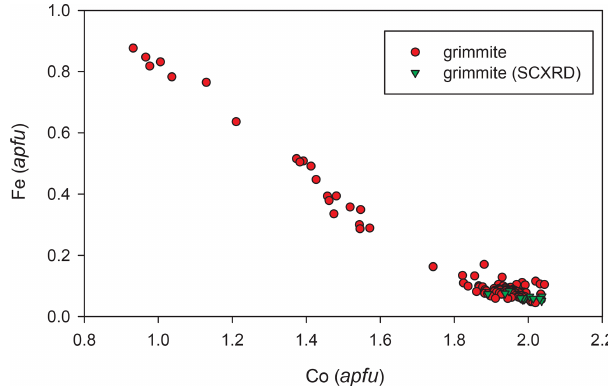
Figure 3. The Co vs. Fe (apfu) graph for all studied grimmite grains from Pˇríbram; SCXRD – grain used for single-crystal study.